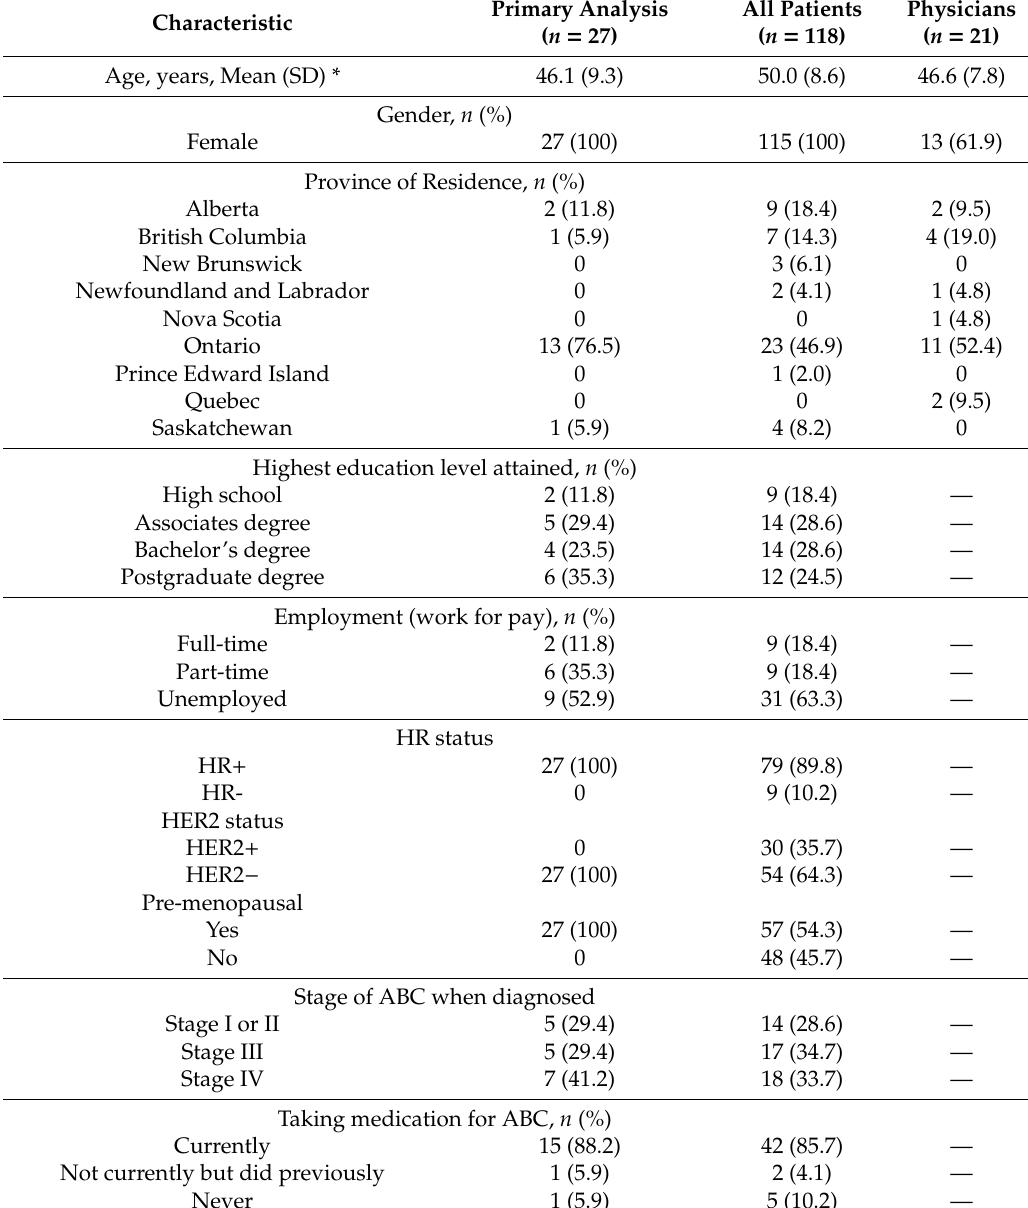
Table 3. Demographic characteristics: patients (all and primary) and